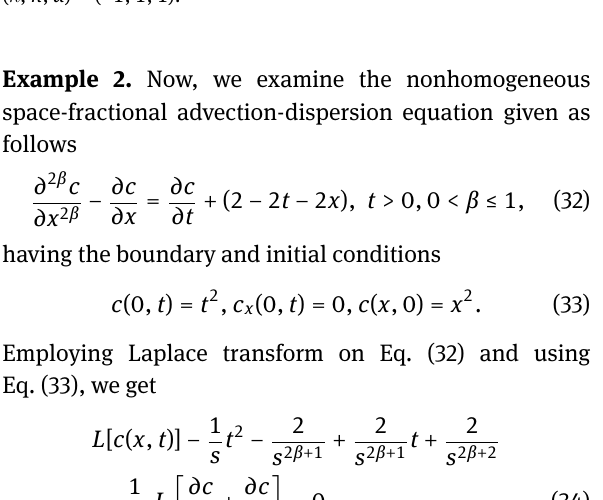
Fig. 1: Approximate solution c for Eq. (22) at k = w = 0.8 and at ( (cid:126) , n , α ) = (−1, 1, 1)